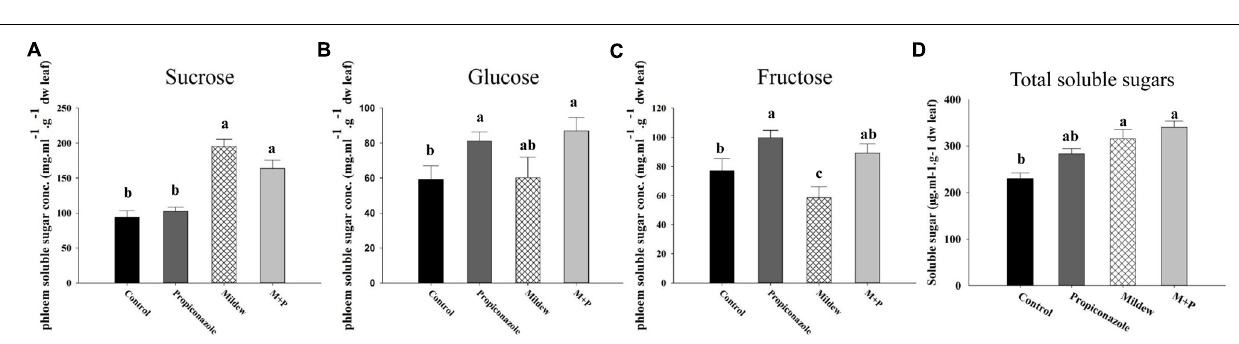
FIGURE 4 | Simple carbohydrates among the four treatments. (A) Sucrose; (B) Glucose; (C) Fructose; (D) Total sugars. Different letters above the bars indicate significant difference among different treatments and the error bars is ± SE bars (five biological replicates, P < 0.05, Tukey’s HSD